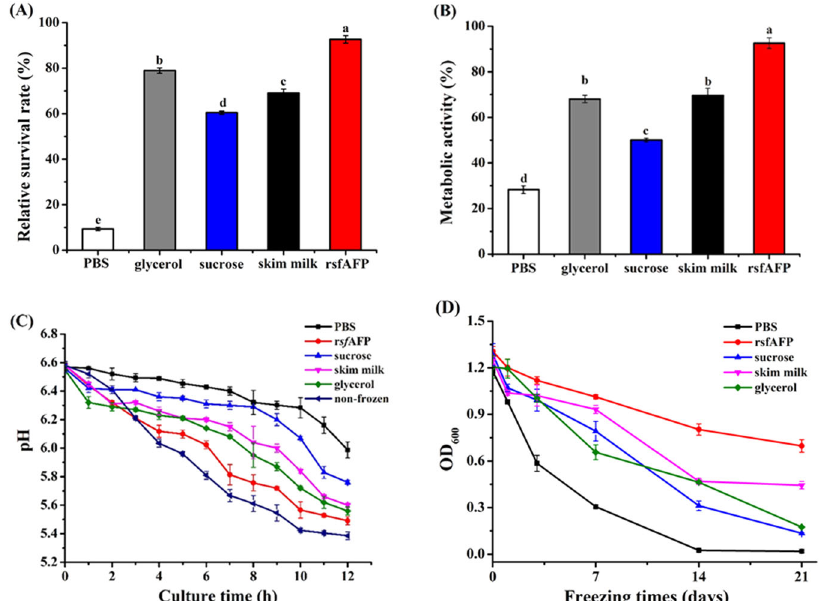
Fig. 4 Cryoprotective effect of rsfAFP on S. thermophilus . A The survival rate of S. thermophilus after freezing at − 20 °C for 24 h and 2 freezing – thawing cycles with various cryoprotectants. B S. thermophilus metabolic activity; C acid production of S. thermophilus with different